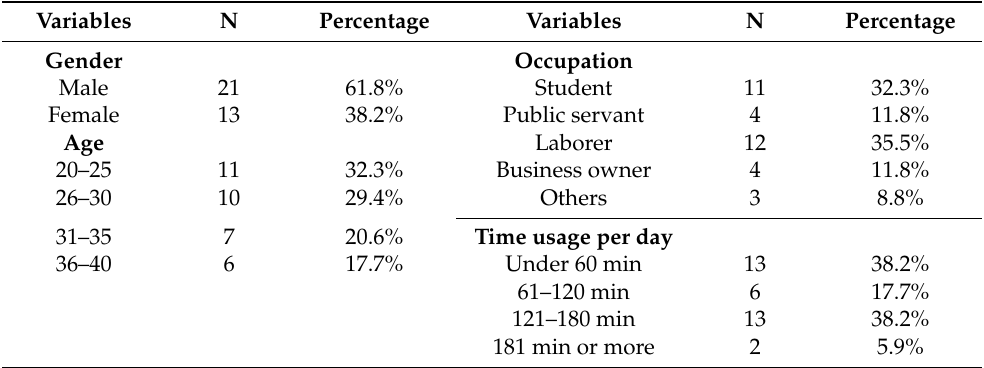
Table 1. Demographics of study participants (N =